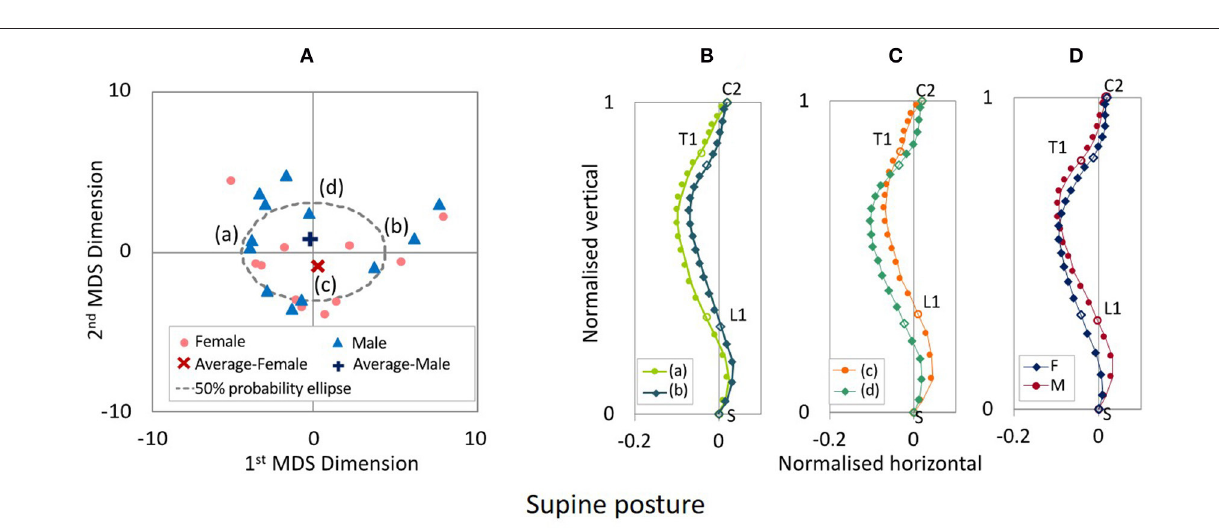
The Pearson product–moment correlation coefficient between the spinal segmental angles is summarized in Table 3 and Figure 9 . For the automotive seating posture in the 20 ◦ and 25 ◦ seat back angles, correlations were observed between CC, TS, and TTK and between LL and SS. There was no correlation seen between cervicothoracic segmental angles and lumber segmental angles in this study. On the other hand, the standing posture had correlations between CC, TS and TTK, and between TTK and LL. For the supine posture, correlations were found between TS and TTK and between LL and